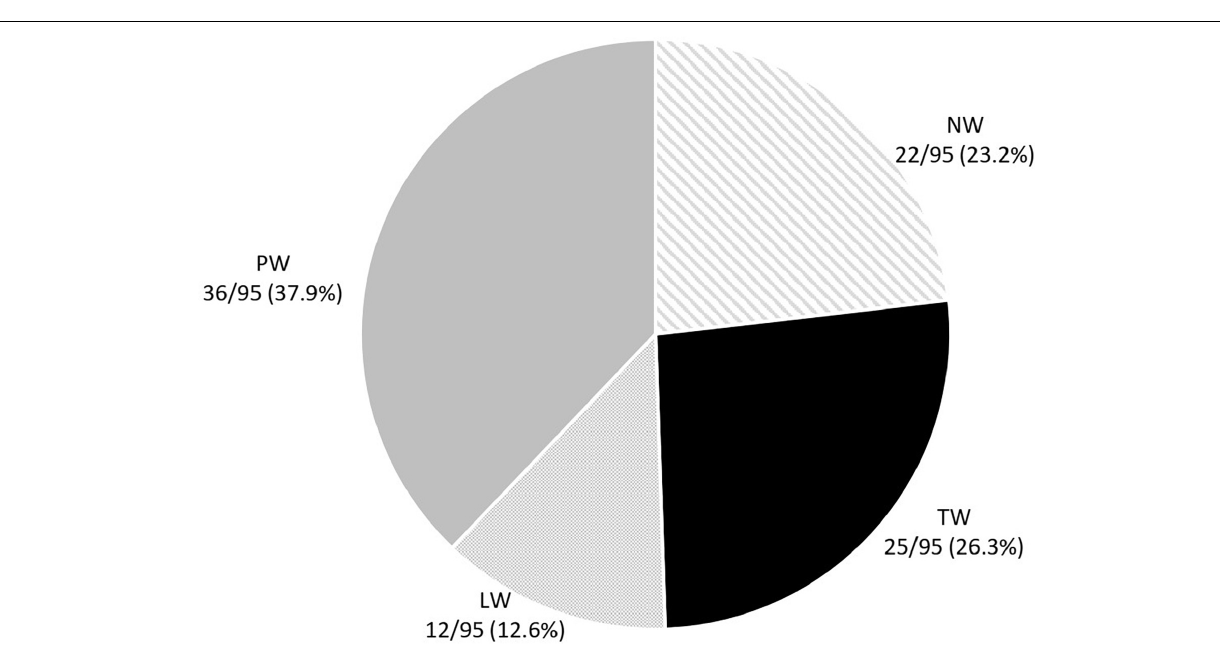
FIGURE 3 | Distribution of the preschool wheezing phenotypes according to the TUCSON* phenotypes. *Tucson phenotypes: TW, transient earlier wheezers; NW, never wheezers; LW, late onset wheezers; PW, persistent wheezers (16). Prevalence of a Positive Bronchodilatory Response respectively ( Table 5 ). Longitudinally, among the 36 patients with early BDR (at 6–8 years), 8 out of 14 (57%) retained this BDR A positive BDR was found in 73.5, 48.5, and 52.9% of children at 10–12 years, and 3/5 at 15–17 years ( Table 5 ). Among the between 6 and 8 years, 10 and 12 years, and 15 and 17 years,